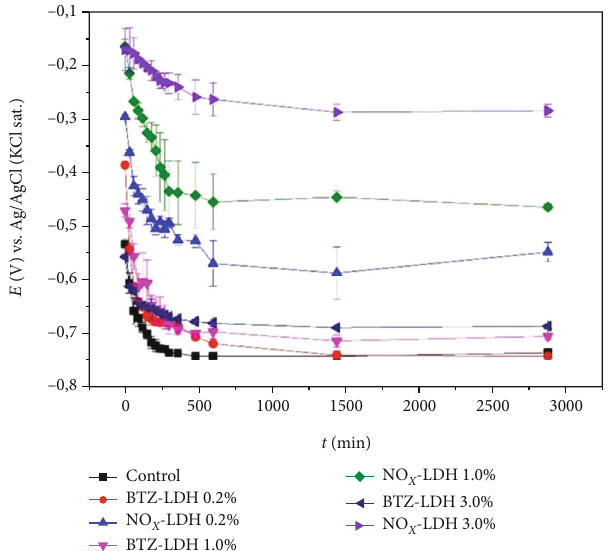
Figure 9: Schematic drawing of ion-exchange process from pristine NO 3.5% NaCl medium.